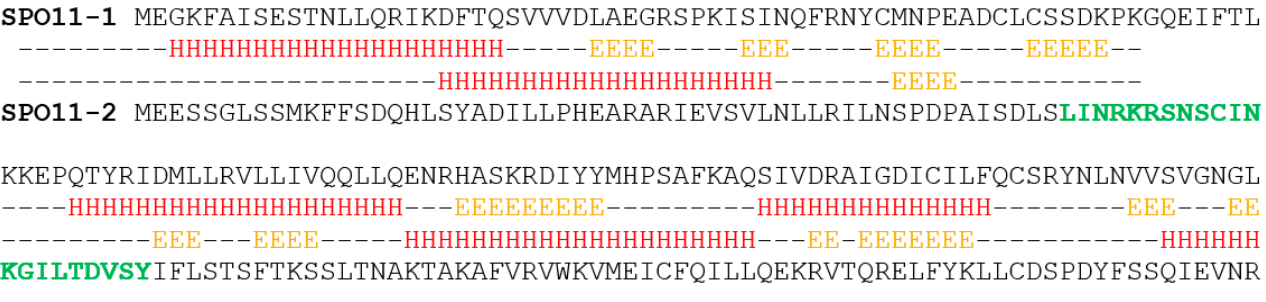
Figure 3. JPred [51] predicted secondary structure of A. thaliana SPO11-1 and SPO11-2. Predicted secondary protein structure of the two meiotic SPO11 paralogs in A. thaliana SPO11-1 (41.81 kilodalton) and SPO11-2 (43.13 kilodalton). Full length protein sequence is shown with subjacent predicted secondary structure. H = alpha helix; E = beta sheet; “–“ = random coil. The 21 amino acids that were used for the production of an N-terminal SPO11-2 antibody are shown in bold green.